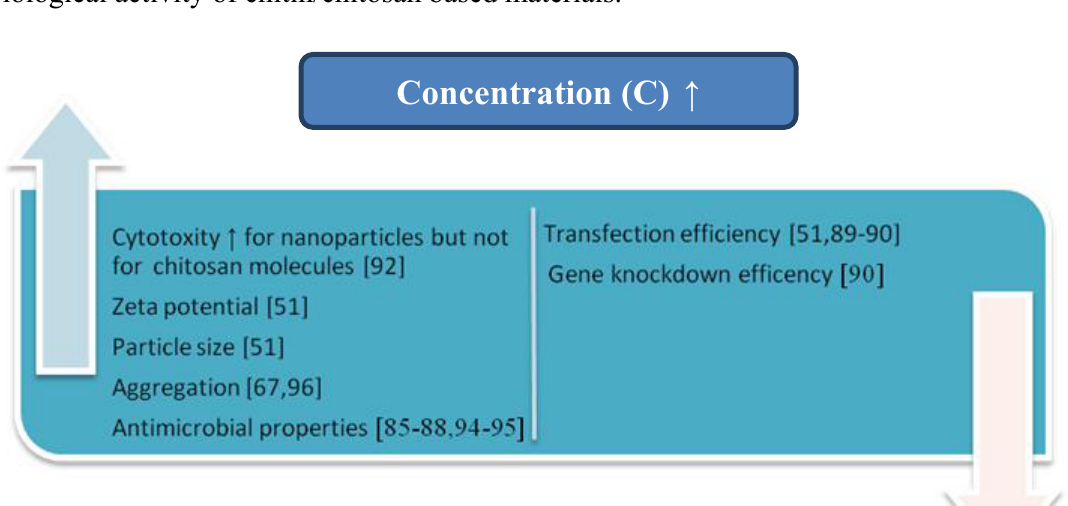
Figure 9. Influence of concentration on the selected physicochemical properties and biological activity of chitin/chitosan based